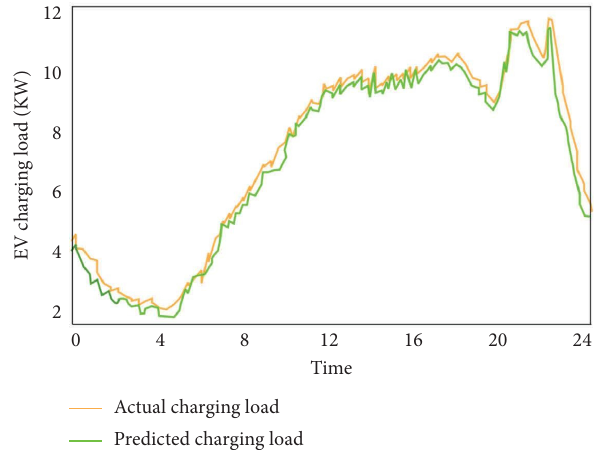
Figure 5: Actual vs. predicted values of hourly EV charging load demand.